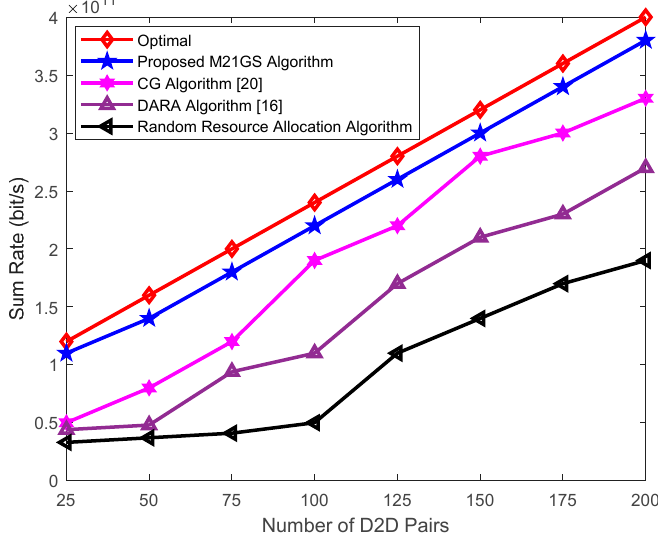
Figure 4. Comparison of the sum rate of the algorithms under different number of D2D users.